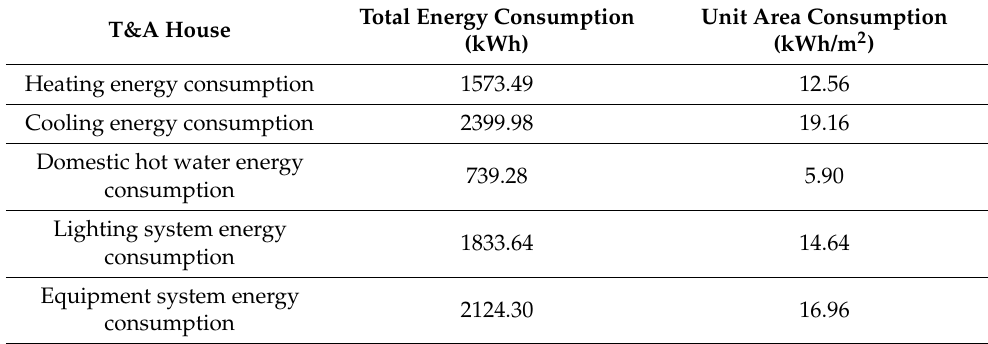
Table 8. Simulation results of energy consumption in T&A House.